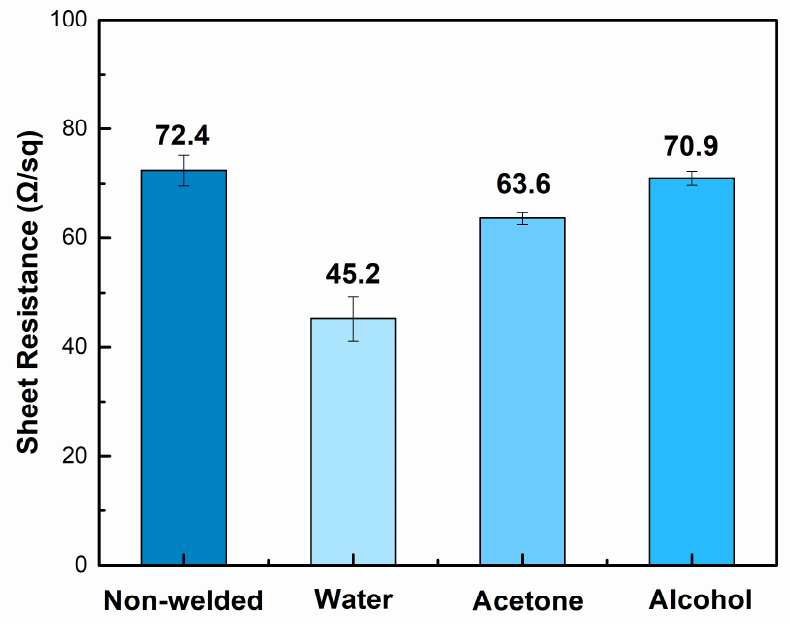
Figure 2. The sheet resistance of SLD‐AgNW films welded with different liquids.